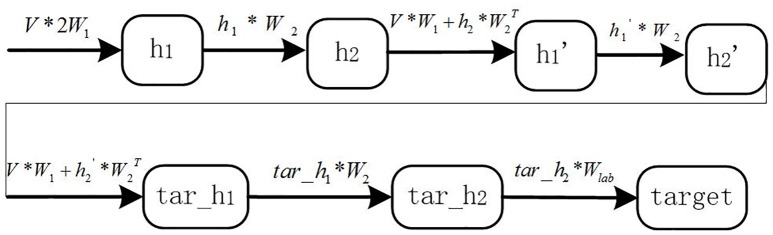
Testing process.